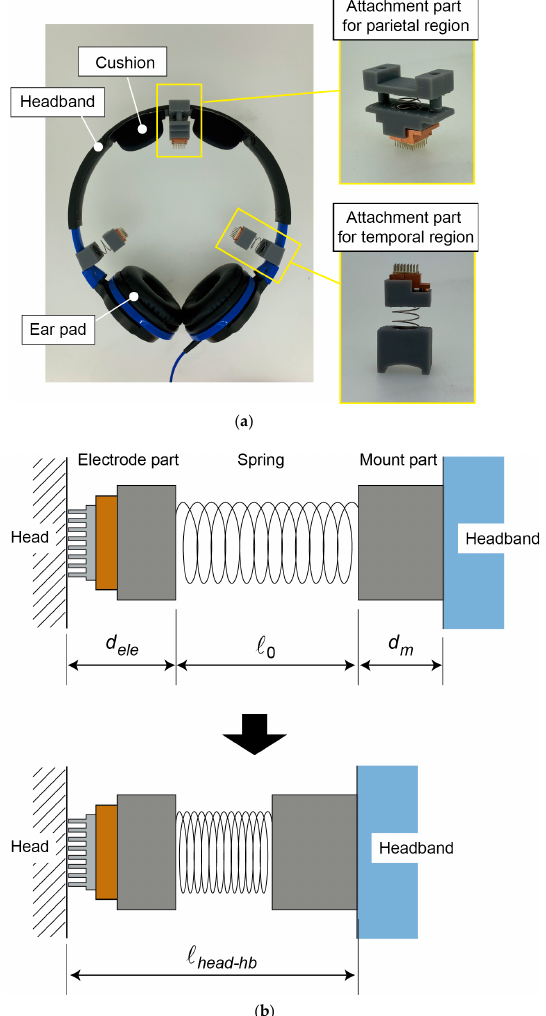
Figure 5. ( a ) Attachment parts of CMEs to headset. ( b ) Detailed design of attachment parts.